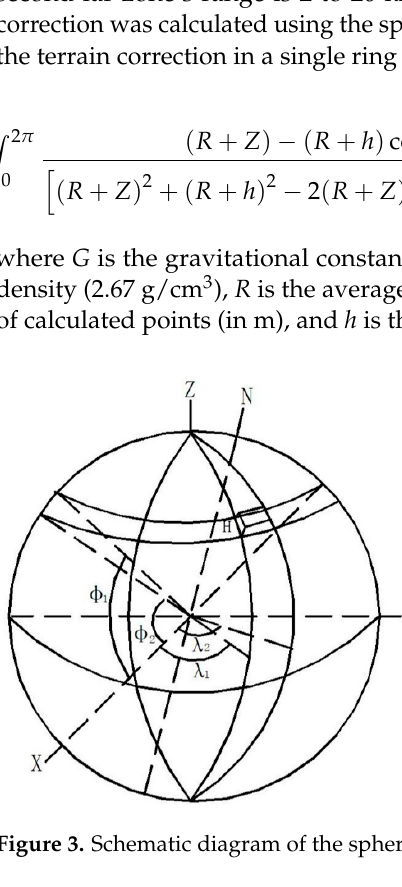
Figure 2. Schematic diagram of the upright prismatic method. ( a ) Measurement point and sur- rounding terrain blocks and ( b ) upright prismatic model.